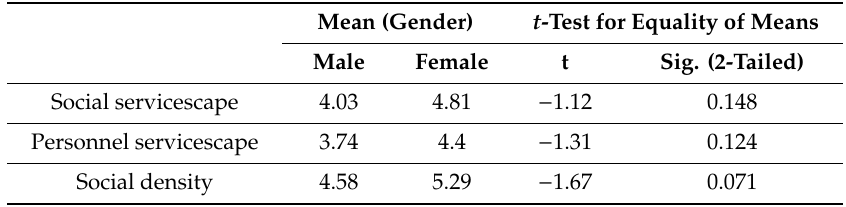
Table 2. Independent samples t -test.